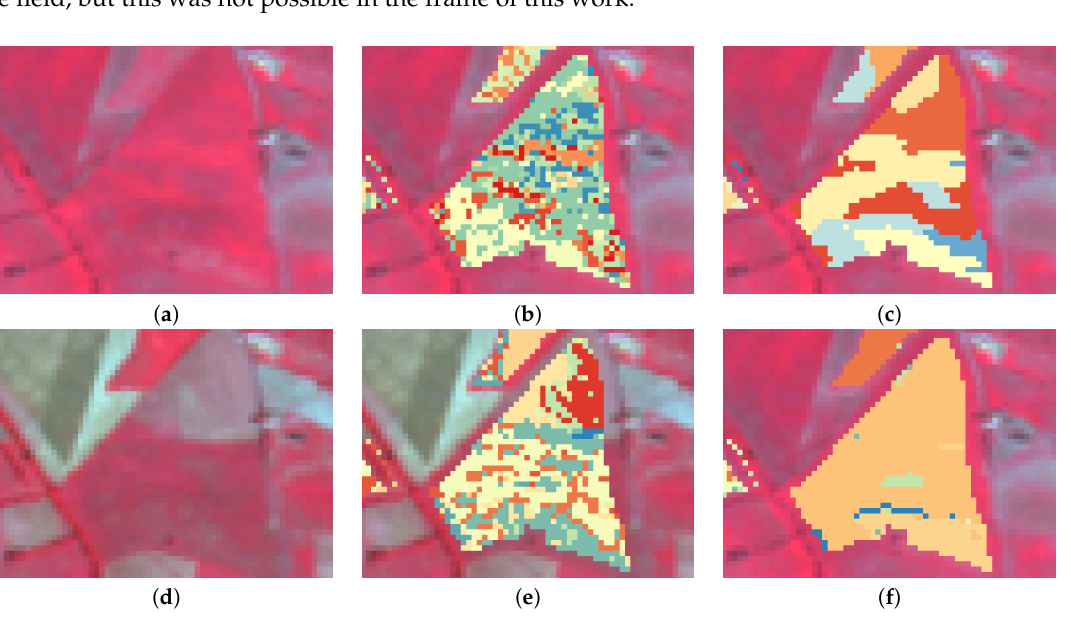
Figure 14. Clustering of the same grassland (false color image of ( a ) 30 April and ( d ) 29 June) with an initial clustering into 150 clusters, using ( b ) the image of 30 April and ( c ) the full SITS, and into 20 clusters, using ( e ) the image of 29 June and ( f ) the full